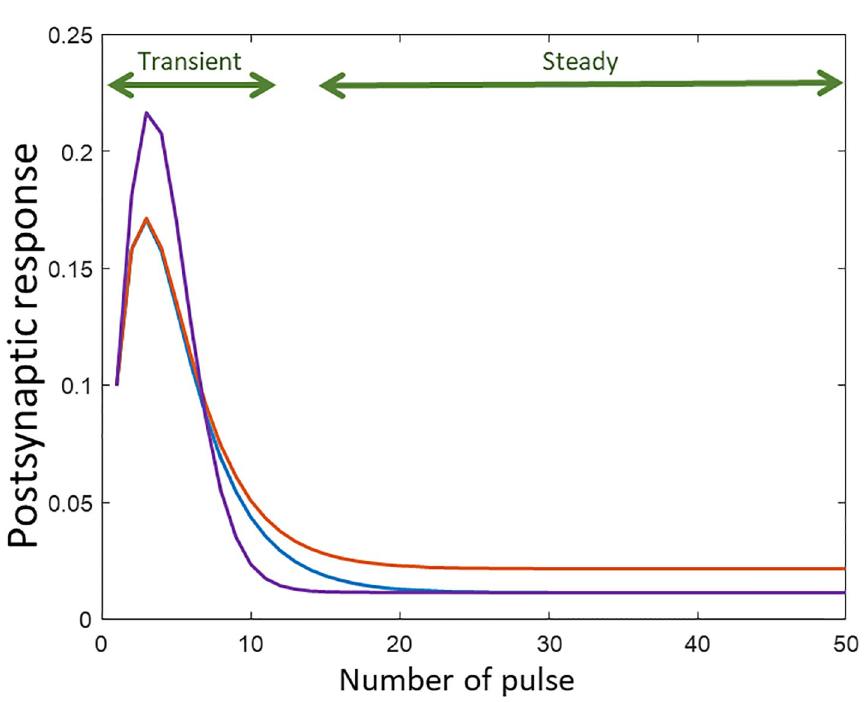
Fig 10. The sensitivity of the transient and steady-state section of the postsynaptic response to changing the TM model parameters. The postsynaptic response of the discrete-time TM model to 50 Hz periodic pulse stimulation. The parameters F , and D are changed to demonstrate the sensitivity of the different sections of the PSC response to these parameters. The transient section is considered as the first part of the response that maximum EPSC is still changing for each spike. The steady section is the following part that PSCs converge to a value and remain unchanged. Considering θ = [ F , D , f , U ] the vectorized form of the parameters: θ blue = [2, 0.05, 0.1, 0], θ red = [1, 0.05, 0.1, 0] and θ purple = [2, 0.5, 0.1, 0]. Considering the blue trace as the reference case changing decreasing D leads to increase in the steady-state value in the red trace. As it is shown despite changing D the transient sections of blue and red traces are almost similar. The purple trace is generated by a larger F which leads to change in the transient state of the PSC response while having a steady-state value close to that of the blue